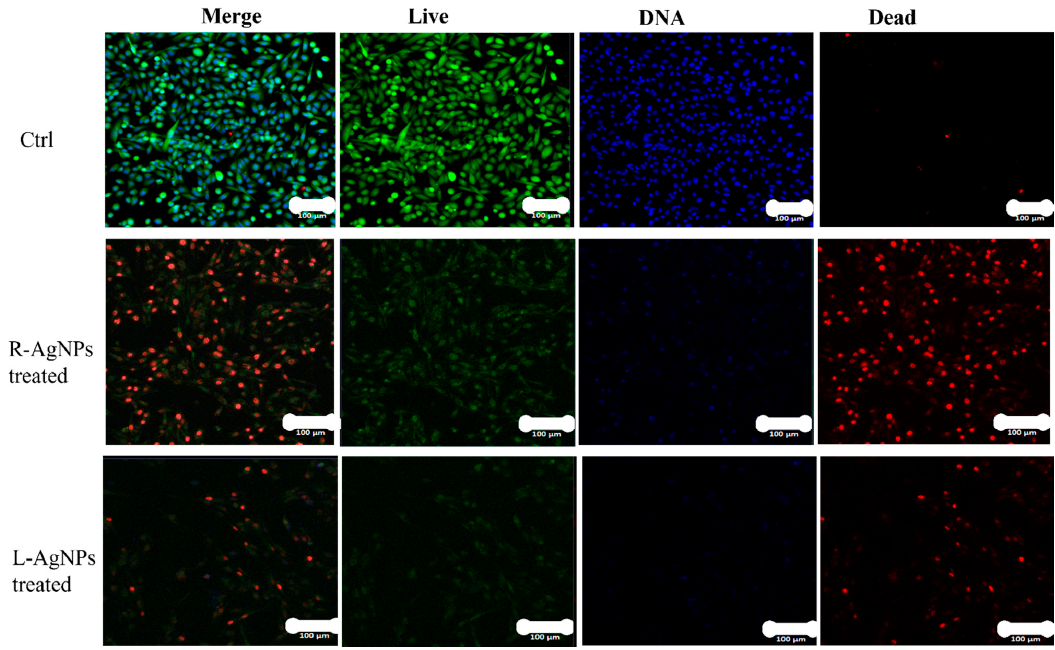
Figure 15. Confocal LSM imaging of L-AgNPs and R-AgNPs treated MDA-MB-231 cell lines as well as untreated control. Cells stained with Propidium Iodide, red (dead), Calcein AM, green (live) and HOECHST33342, blue (DNA). Overlay of all three stains (merge). Cells that had a bright green fluorescence were live cells. Cells with a bright blue colour indicated fragmented nuclei involving concentrated chromatin and were identified as apoptotic cells.